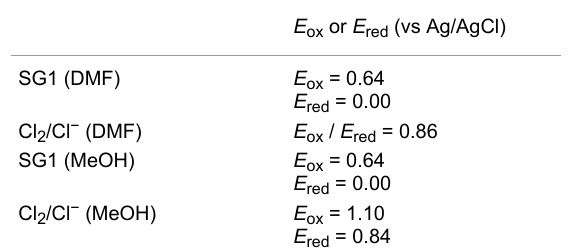
SG1 (DMF) E ox = 0.64 Cl 2 /Cl − (DMF) E ox / E red = 0.86 SG1 (MeOH) E ox = 0.64 Cl 2 /Cl − (MeOH) E ox = 1.10